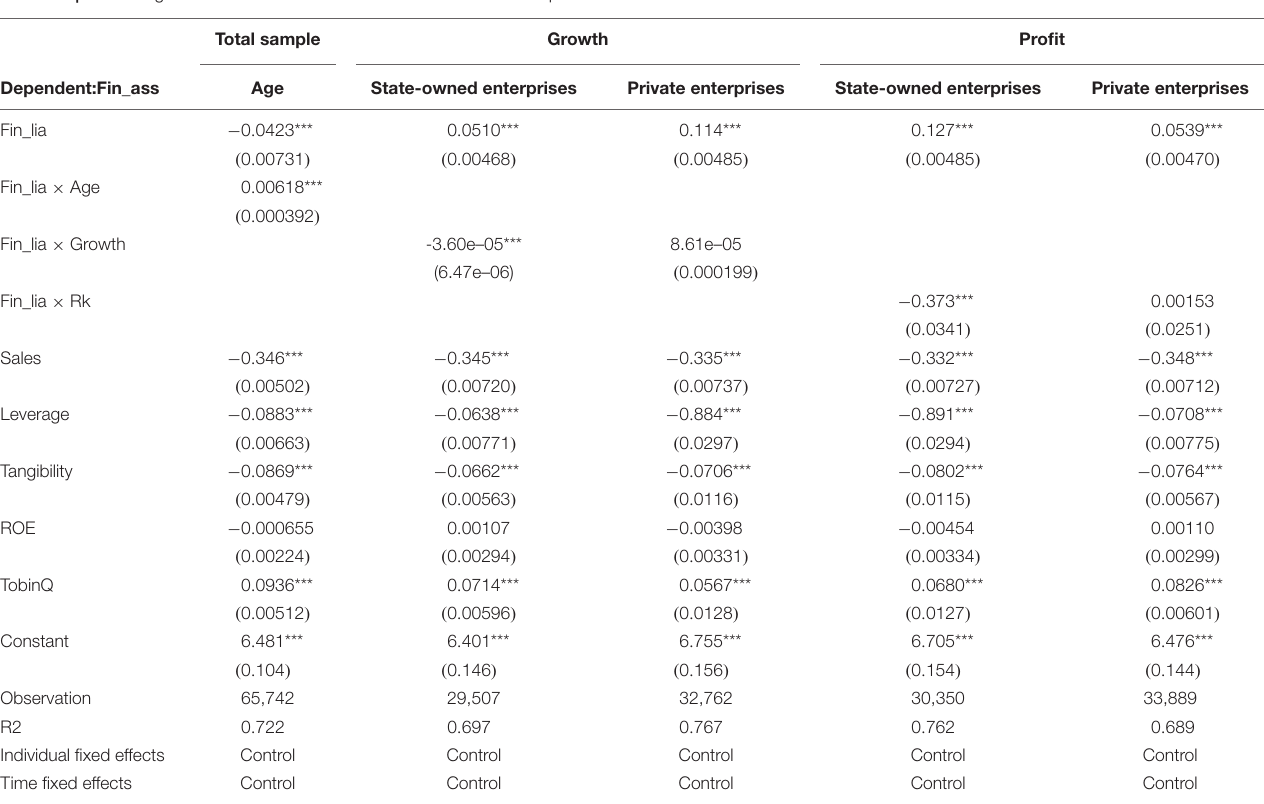
TABLE 6 | Influencing factors and “Borrow to Lend” activities at the enterprise